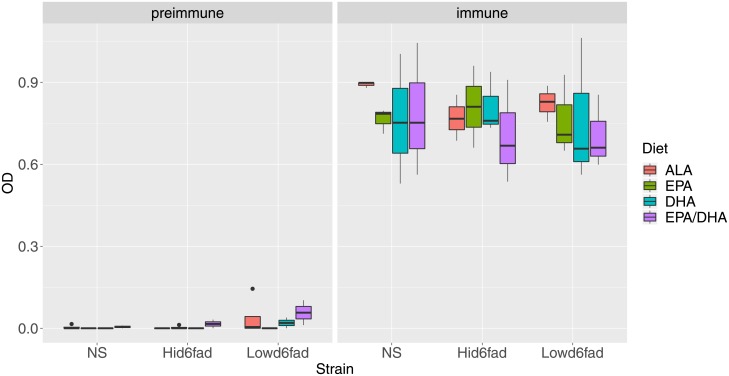
ELISA plot.Comparison of IgM titers in fish 62 days after immunization. Plasma from preimmune (n = 36) and vaccinated fish (immune, n = 36) were used to perform ELISA assay. Data expressed as OD adjusted for background. T-test used to calculate difference between immune and preimmune and ANOVA for multiple comparison between each variable (strain and diet).